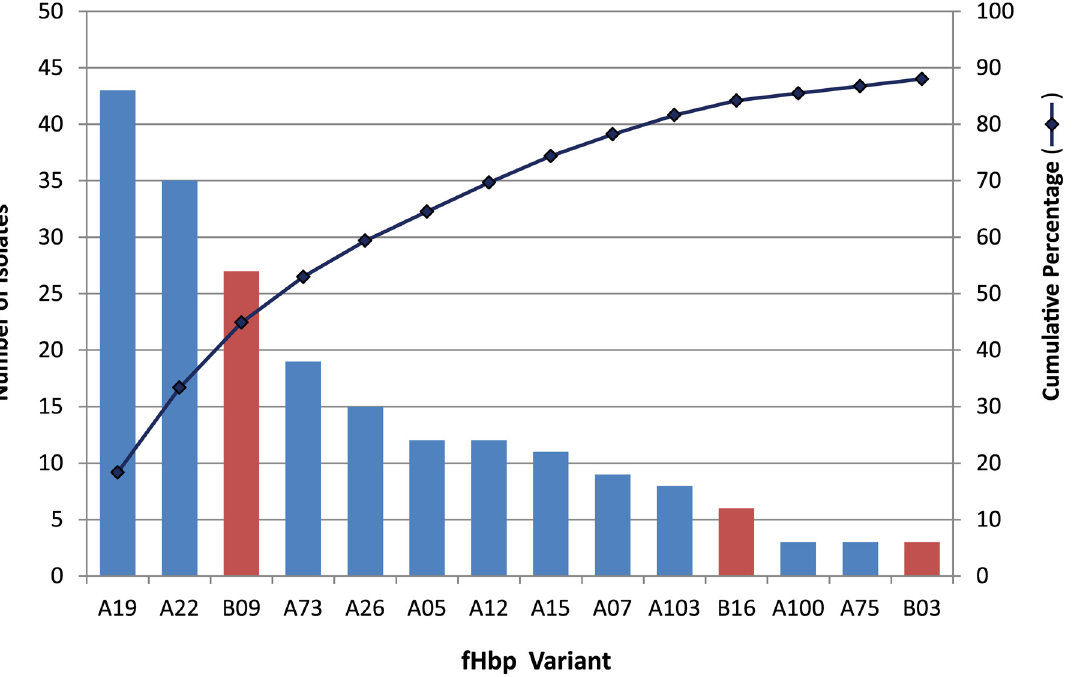
Fig 2. Diversity of the fHbp variants in the carriage isolate collection. Distribution of fHbp variants found in three or more isolates. Fourteen fHbp variants encompassed 206 (88%) isolates in the collection. Blue bars, fHbp subfamily A variants; red bars, fHbp subfamily B variants.